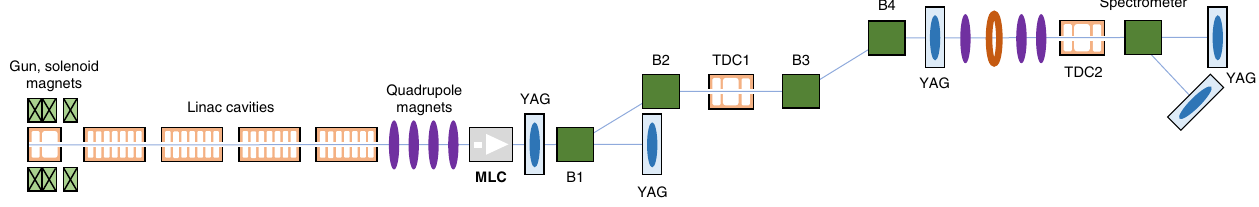
FIG. 1. AWA drive linac and EEX beamline (not to scale), adapted from [18] to include the MLC. There are six linac cavities at the AWA, but two cavities were not used in this experimental